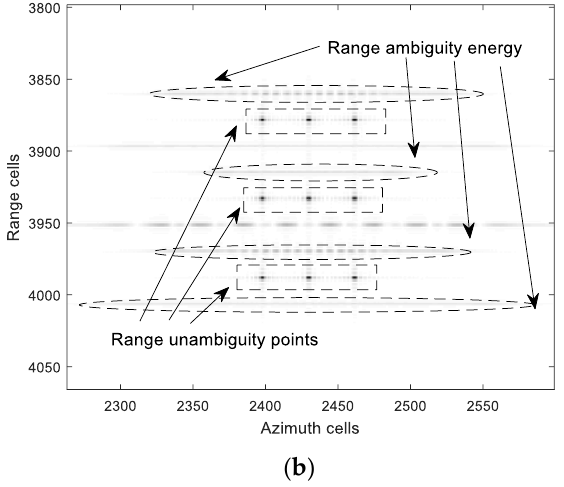
Figure 11. Results of the traditional method: ( a ) echo data after the range pulse compression; ( b ) echo data after the azimuth compression.